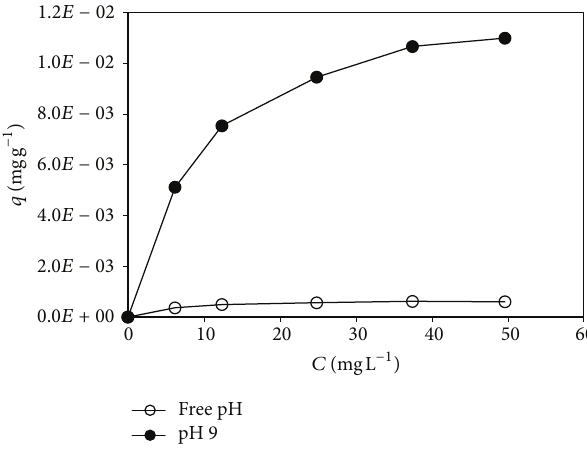
Figure 3: Effect of pH on adsorption of MET over TiO 2 at 25 ∘ C, pH 9 ( ∙ ), and free pH ( I